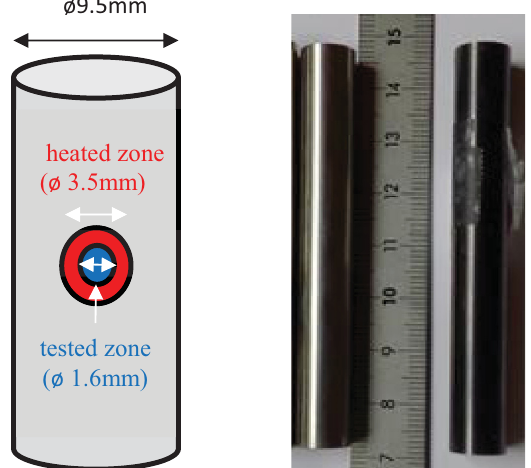
Fig. 6. On the left: schematic comparison of the Zy4 cladding diameter and those of the heated zone (in red) and of the tested zone on it (in blue). On the right: the picture of Zy4 claddings. Some Zy4 claddings were arti fi cially oxidized (on the right in the picture).